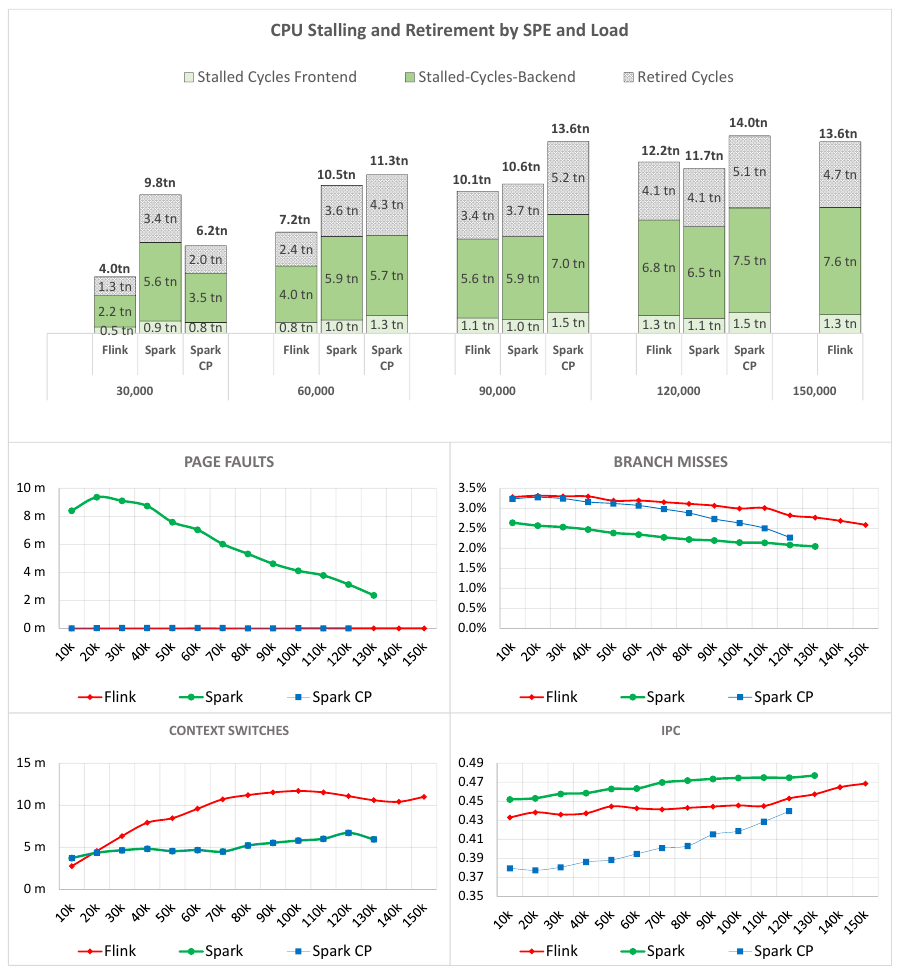
Figure 10. CPU stalling behavior when increasing